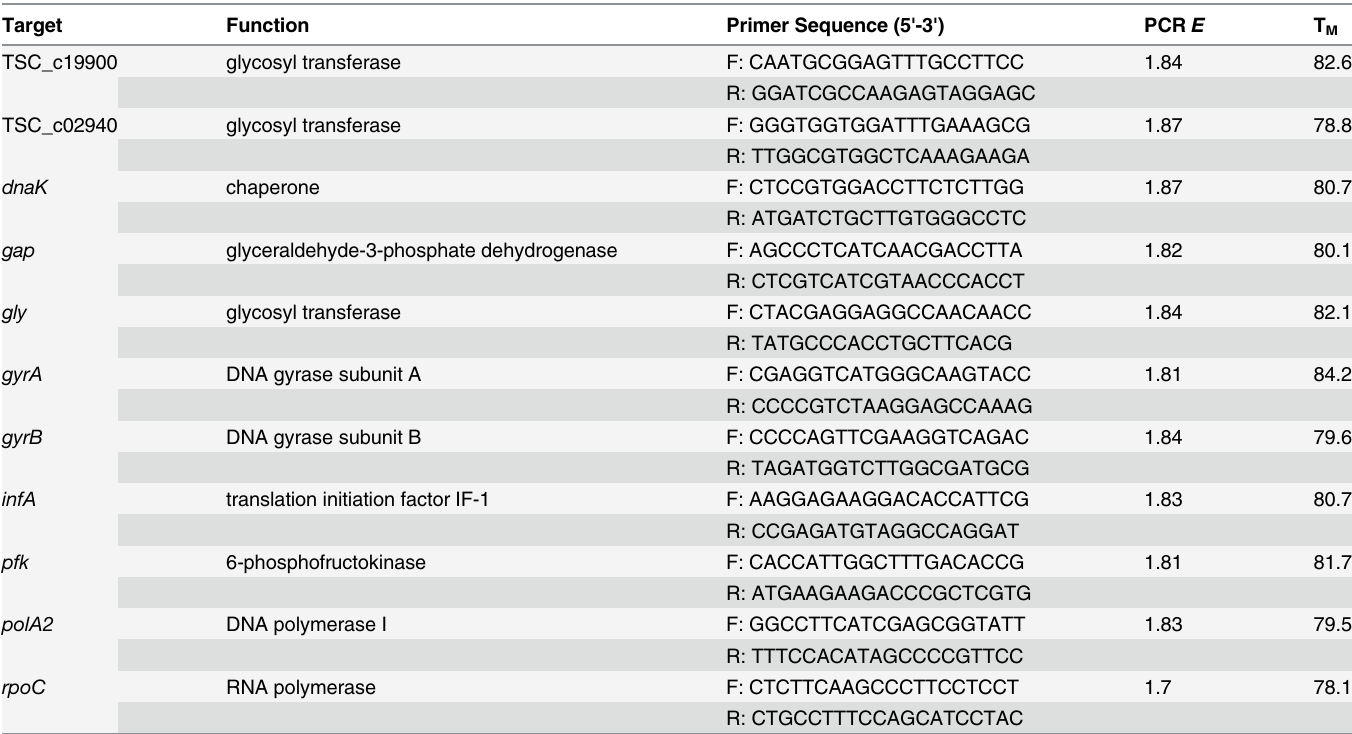
Table 2. Function, primer sequence, PCR efficiency (PCR E ) and melting temperature (T M ) of candidate reference genes developed in this study.